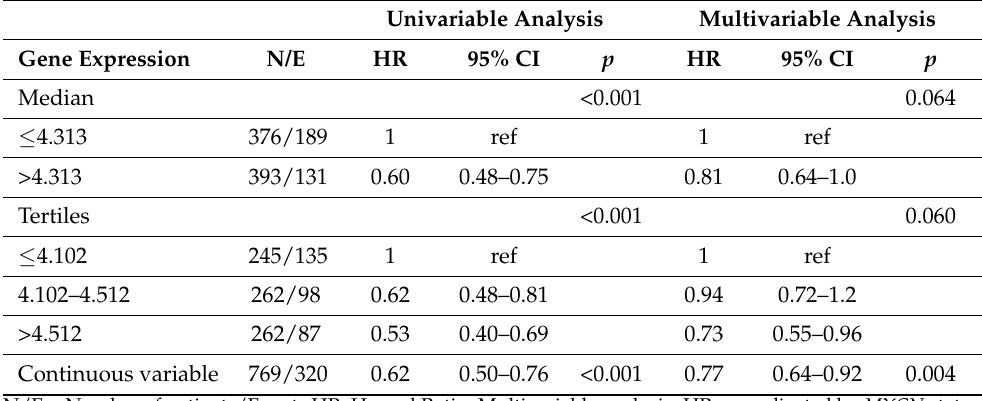
Table 22. Event Free Survival of 769 NB patients in relation to LPIN1 expression levels evaluated by the Cox regression